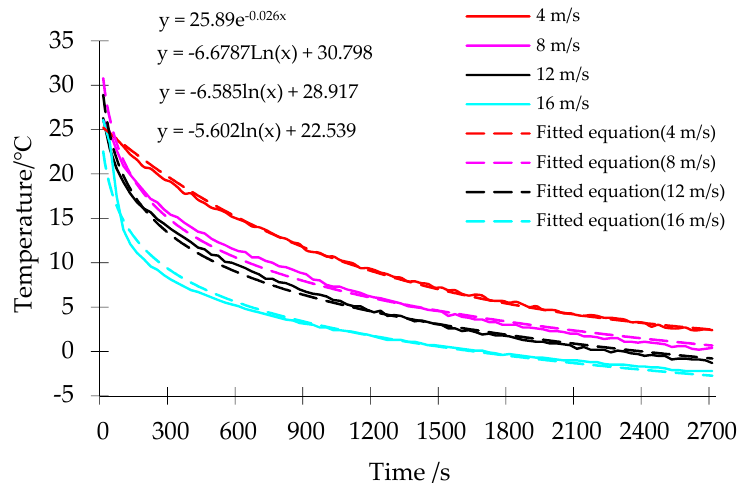
Figure 2. User-defined function (UDF) equation of the inlet temperature over time.